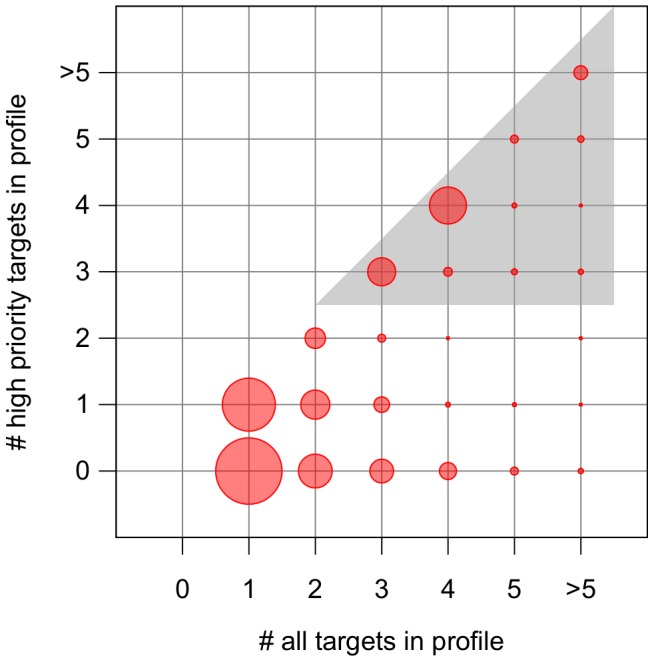
High priority targets versus total number of targets within a predicted profile.The size of a circle relates to the number of compounds that address a profile of the given characteristics.